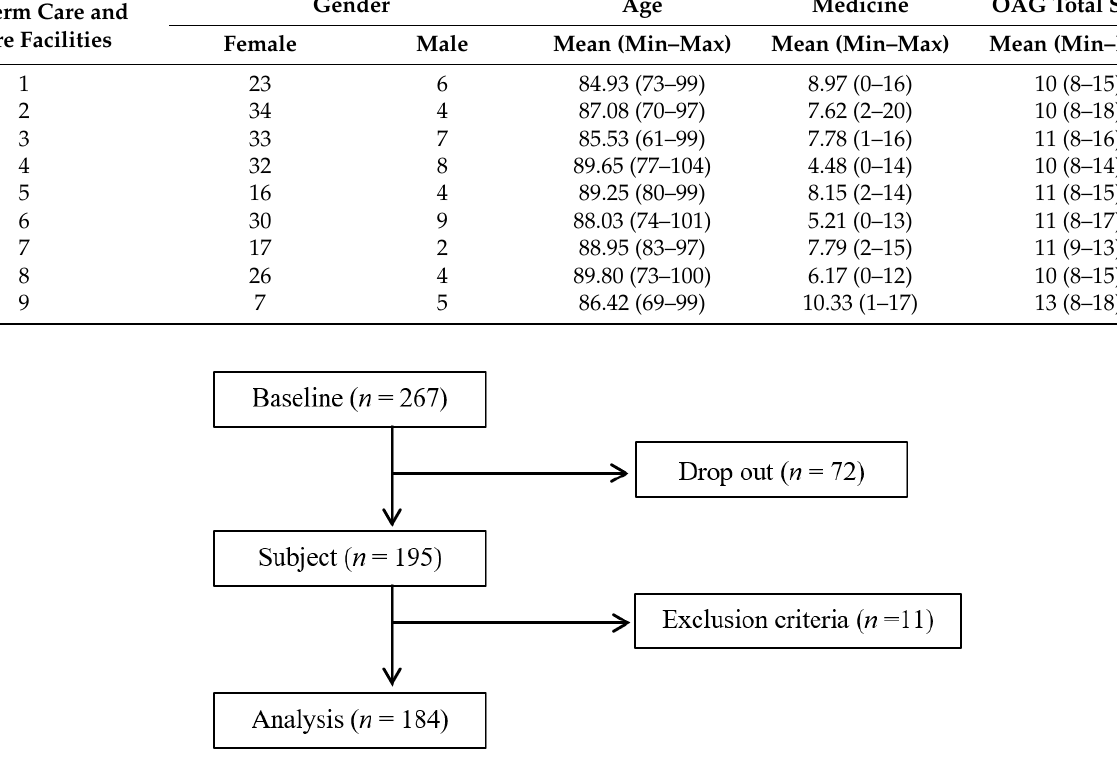
Figure 1. Subject Figure 1. Subject diagram. Table 1. Subject information at baseline.